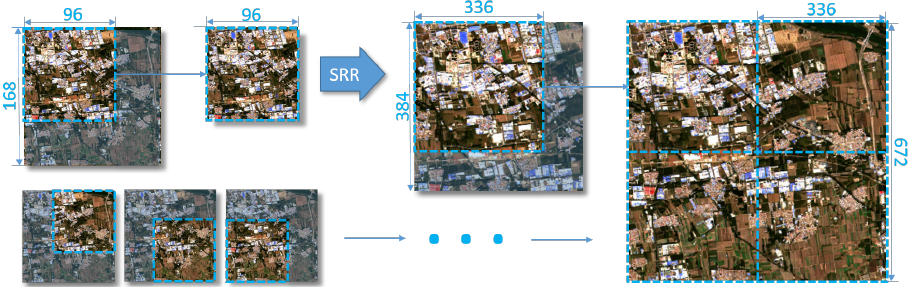
Figure 6. The pipeline of clipping-and-merging method. The input image is cropped into four patches with overlaps. Each patch is upsampled by 4 times through our networks, namely, 384 × 384 pixels. Half of overlap in each patch is clipped, and thus the patches get size of 336 × 336 pixels, namely a quarter of result. Therefore, four patches predicted by the aforementioned method compose the whole upsampling